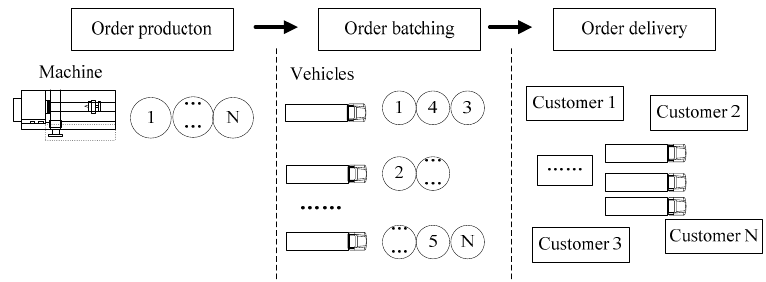
Figure 1. The integrated production and distribution scheduling procedure.